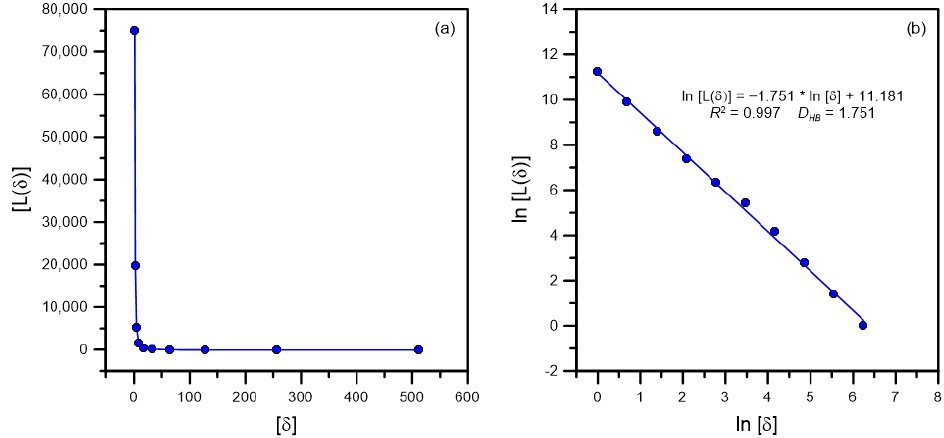
Figure 1. Estimation of the fractal dimension of the third iteration of the Sierpinski carpet. ( a ) Power- law and ( b ) double logarithmic representations.